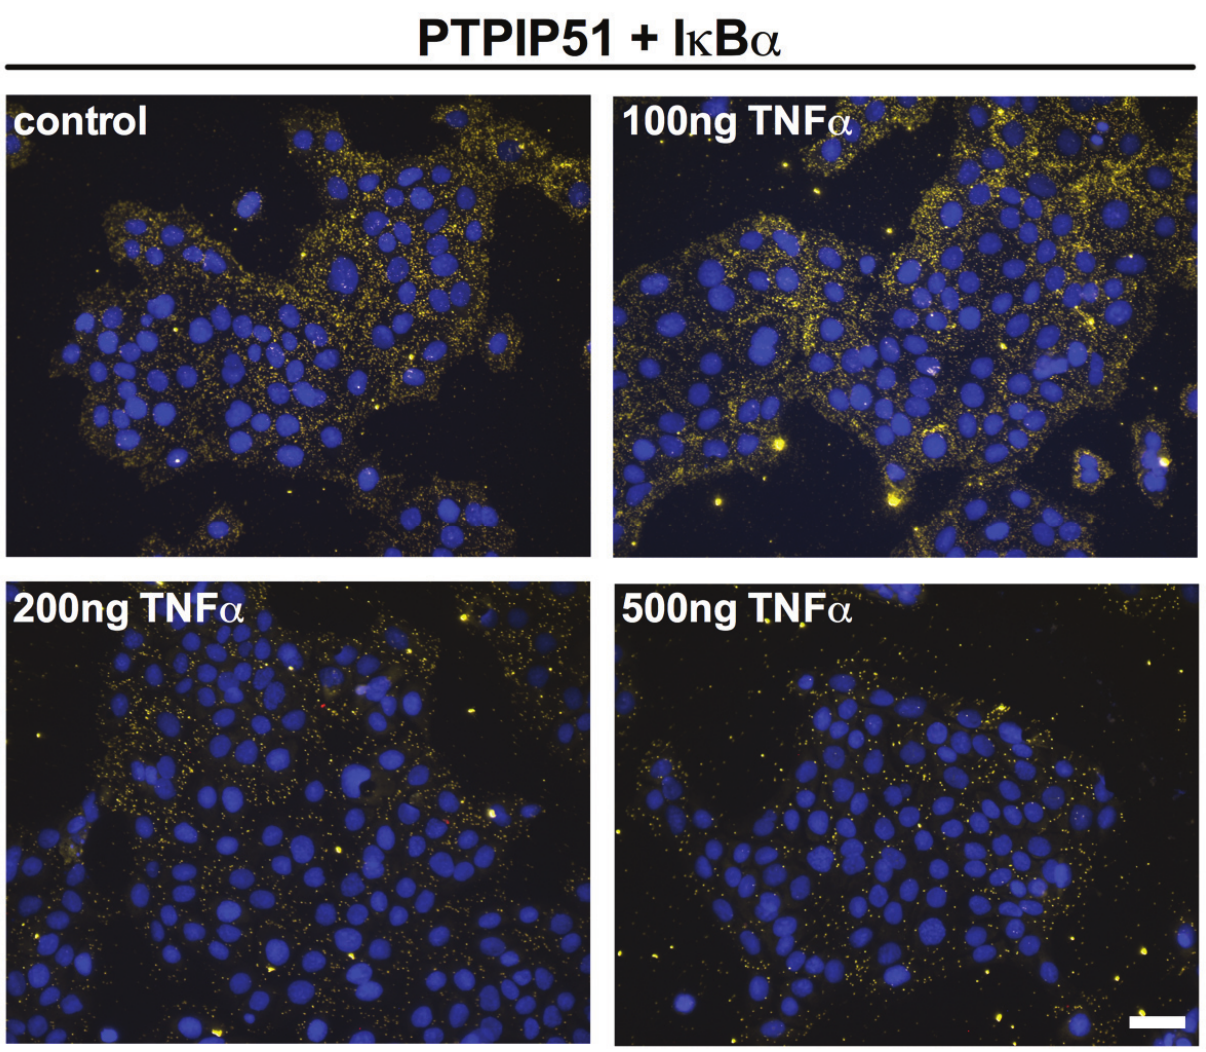
Figure 7. Interactions of PTPIP51 and IkB(cid:3) in human keratinocytes determined by Duolink proximity assay. Untreated controls, 100 ng/mL TNF(cid:3) treated cells, 200 ng/mL TNF(cid:3) treated cells, 500 ng/mL TNF(cid:3) treated cells. Bar: 20